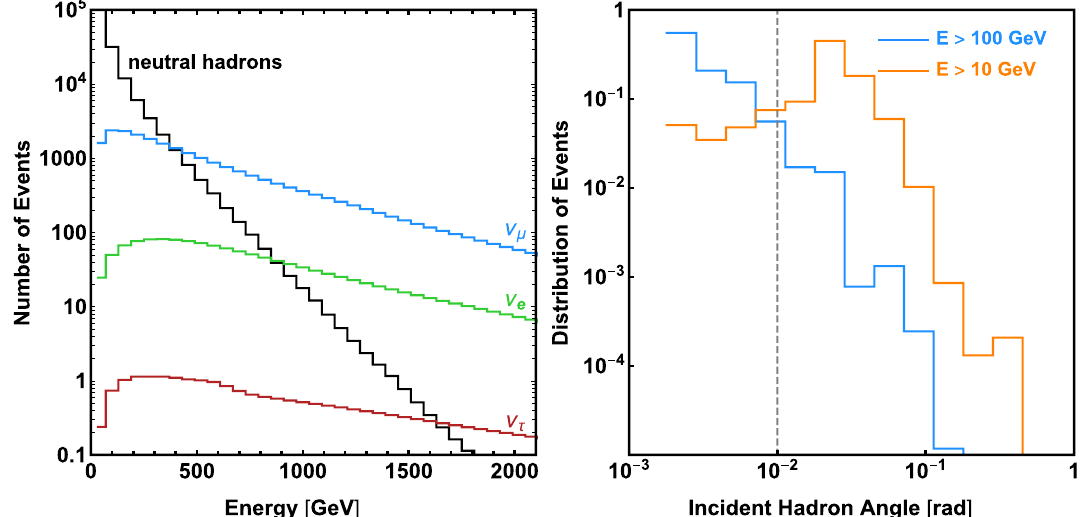
Fig. 15 The energy and angular distributions of neutral hadrons that are produced by negative muon interactions and pass through FASER ν in Run 3. Left : The energy spectrum of neutral hadrons produced in the rock in front of FASER ν and produced within the detector (black) as wellasneutrinosinteractingwiththedetectorforanintegratedluminos- ity of 150 fb − 1 : ν e (red), ν μ (blue) and ν τ (green). Right : The angular